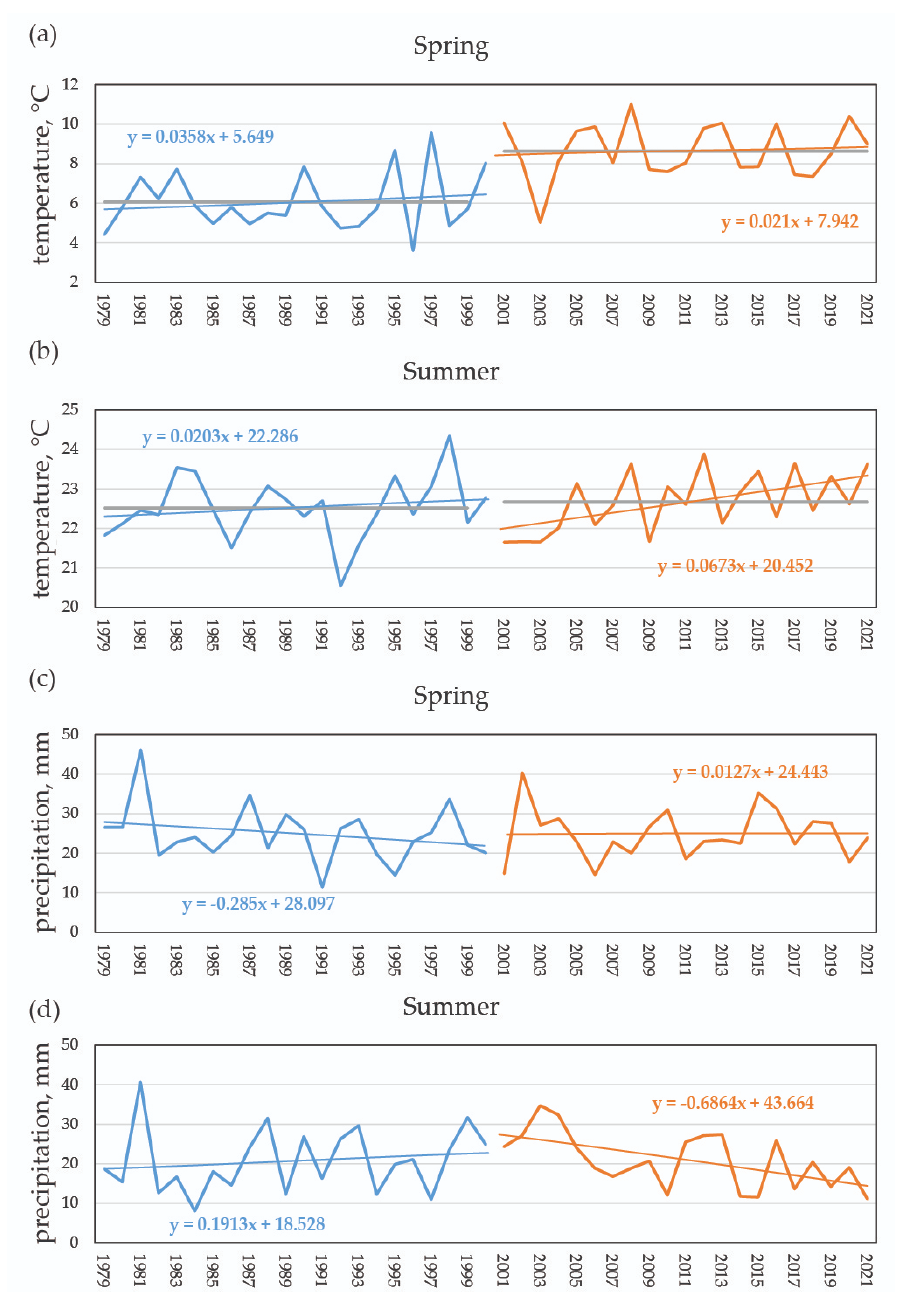
Figure 2. The temporal variability of the air temperatures ( a , b ) and monthly precipitation ( c , d ) averaged over spring (MAM) and summer (JJA) months in Kazakhstan. The linear trends are separately shown for the periods 1979–2000 and 2001–2021. The mean air temperatures for the selected periods are shown by gray